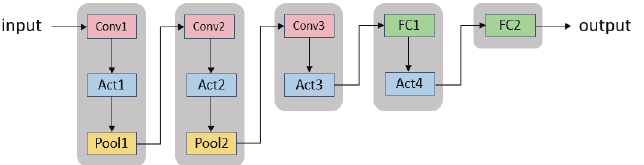
Figure 6. Architecture of LeNet-5. There are four activation units lying in four layers correspondingly, illustrated by blue